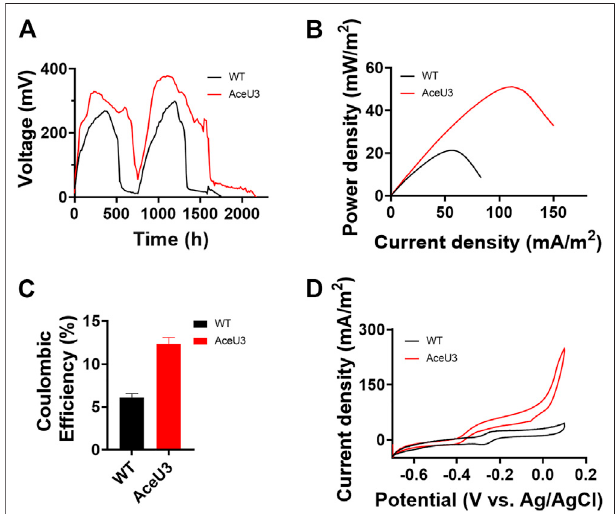
FIGURE 4 | Electrochemical performances analysis of WT and ET S. oneidensis in MFCs with lactate as carbon source. (A) Output voltage curves changed a part of anolyte with fresh anolyte when output voltage was completely declined. Catholyte was changed whenever needed. (B) MFCs power density output curves obtained by linear sweep voltammetry (LSV) with a fi xed scan rate of 0.1 mV/s. (C) Coulombic ef fi ciency of MFCs which inoculated WT and AceU3. (D) Cyclic voltammetry (CV) analysis of four strains. All error bars were calculated from triplicate